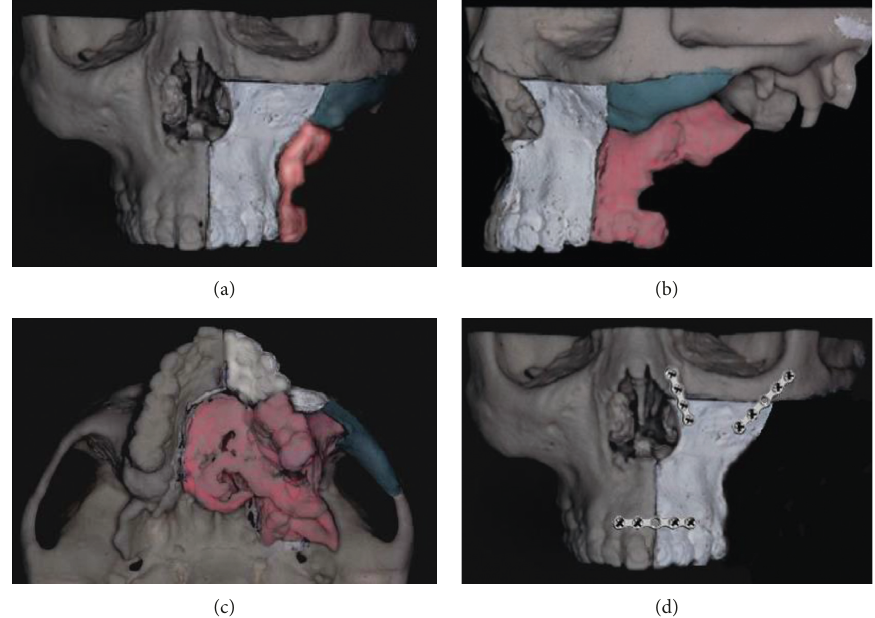
Figure 4: (a) Frontal view of model surgery. (b) Lateral view of model surgery. (c) Look-up view of model surgery. (d) View after tumor was resected, and the anterior maxilla flap was fixed with three